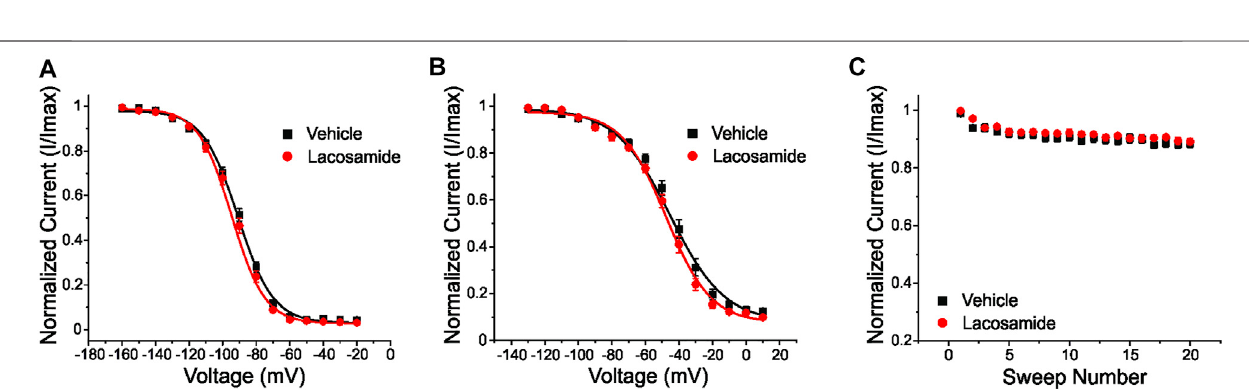
FIGURE 2 | The local anesthetic binding site (F1737/Y1744) in the channel pore is necessary for inhibition of Na V 1.7 by lacosamide. The clinically-achievable concentration (30 μ M) oflacosamide does not block Na V 1.7 channels with a disabled LA binding site (F1737A/Y1744A). (A) Nodifferencein the voltage-dependence of steady-state fast-inactivation was observed with the application of 30 μ M lacosamide in mutant Na V 1.7 channels lacking a functional LA binding site. (B) Similarly, the voltage-dependence of slow-inactivation was unchanged. (C) Abolishing the LA binding site resulted in no appreciable effects of lacosamide on Na V 1.7 use- dependent inhibition at 20